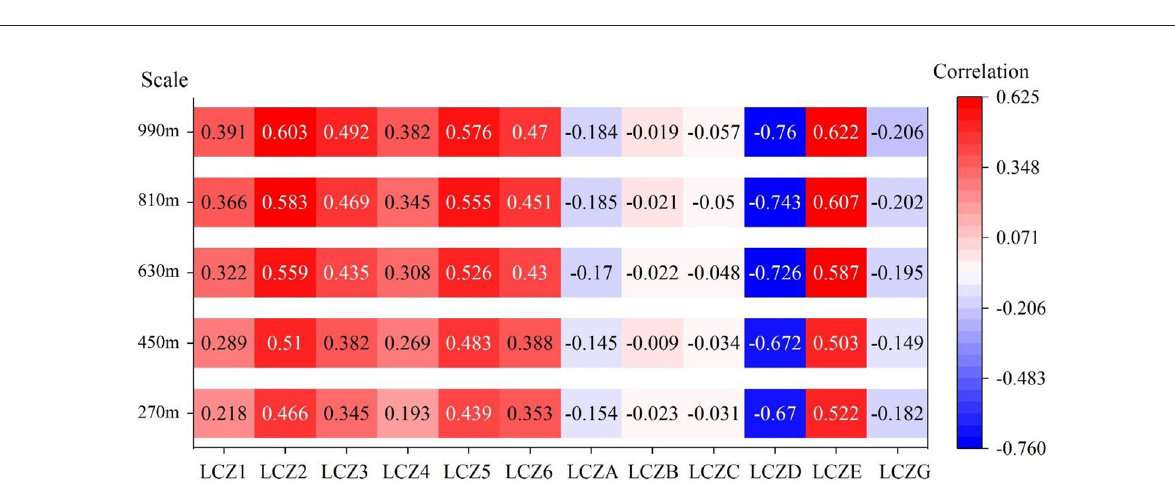
LCZE. Only three LCZs significantly affected the increase of